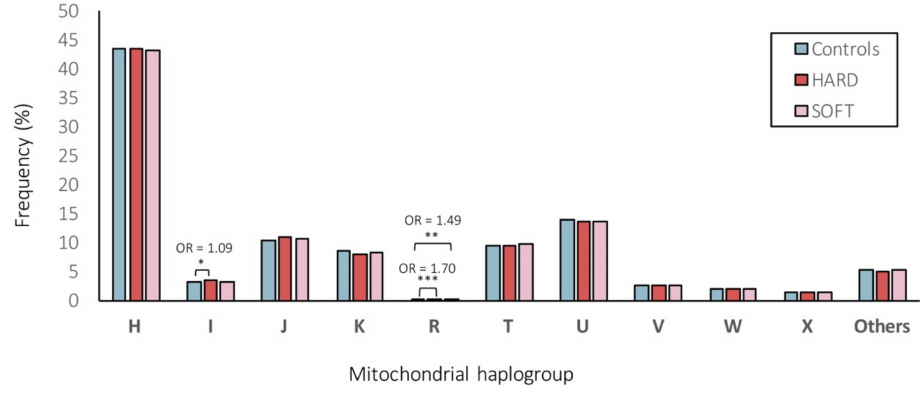
Figure 4. Frequencies (%) of mitochondrial (MT) haplogroups within HARD and SOFT CAD pheno- types vs. controls. ***, ** and * represent statistically significant (of p < 0.001, p < 0.01 and p < 0.05, respectively) differences between the comparison